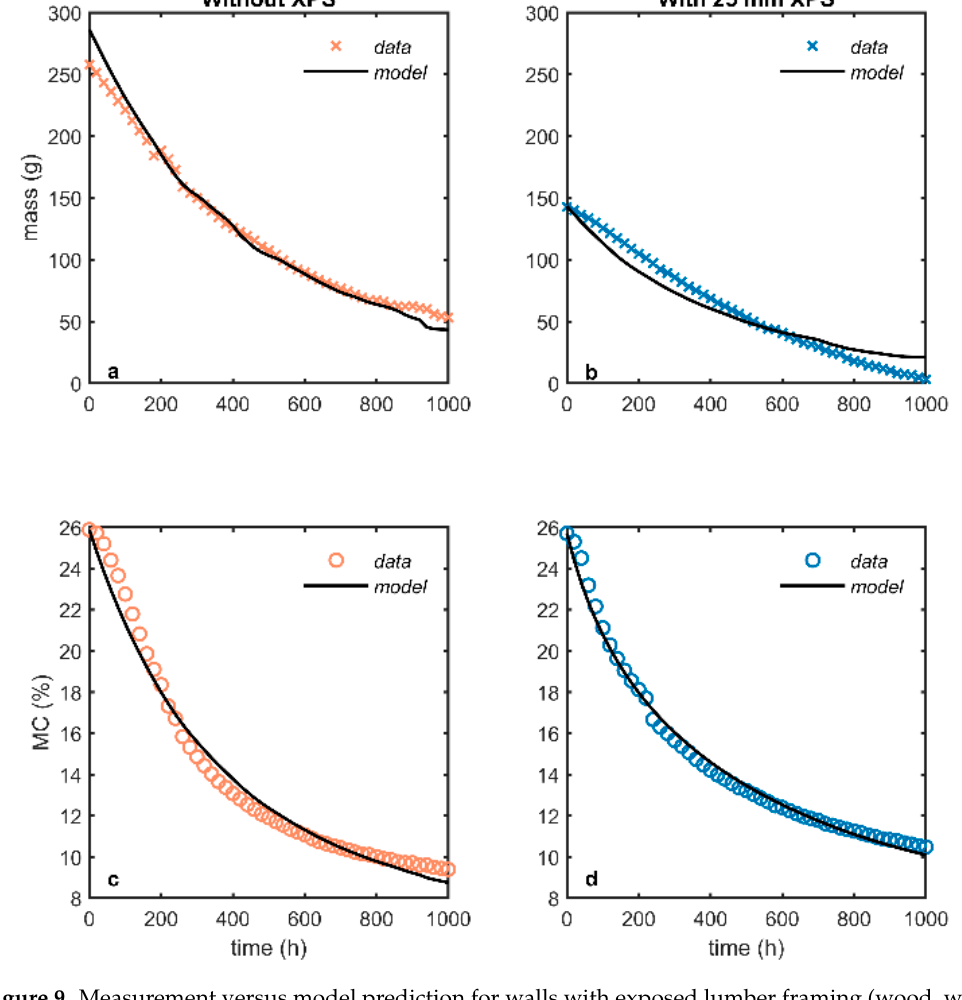
Figure 9. Measurement versus model prediction for walls with exposed lumber framing (wood, w/o XPS and wood, w/ XPS). Subfigures ( a ) mass results, and ( c ) MC results, represent the wall without XPS covering the OSB, while ( b ) mass results, and ( d ) MC results, represent the wall with 25 mm XPS insulation covering the OSB.